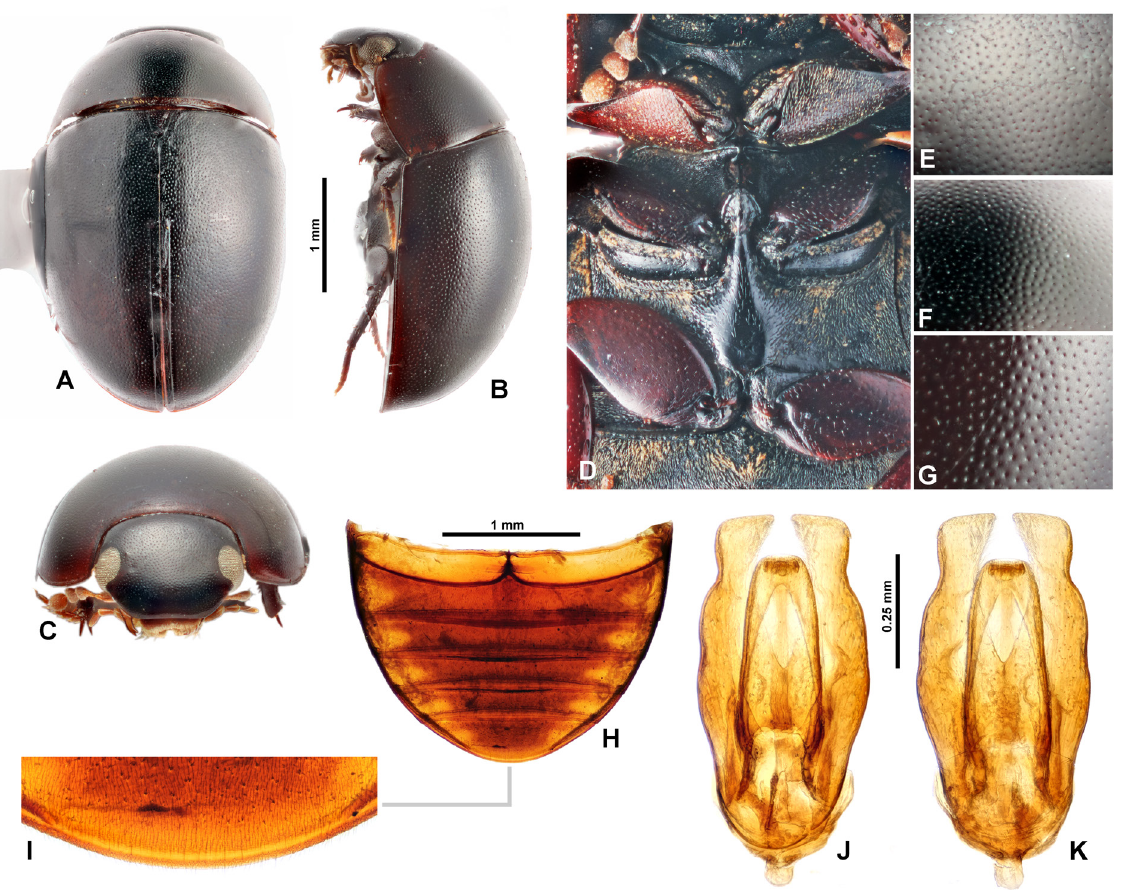
Fig. 6. Coelostoma (s. str.) lyratum sp. nov., holotype, ♂ (NMPC). A . Dorsal habitus. B . Lateral habitus. C . Frontal view. D . Thorax in ventral view. E . Dorsal punctation of head. F . Dorsal punctation of pronotum. G . Dorsal punctation of elytron. H . Abdominal ventrites. I . Detail of abdominal apex. J–K . Aedeagus: ventral (J) and dorsal